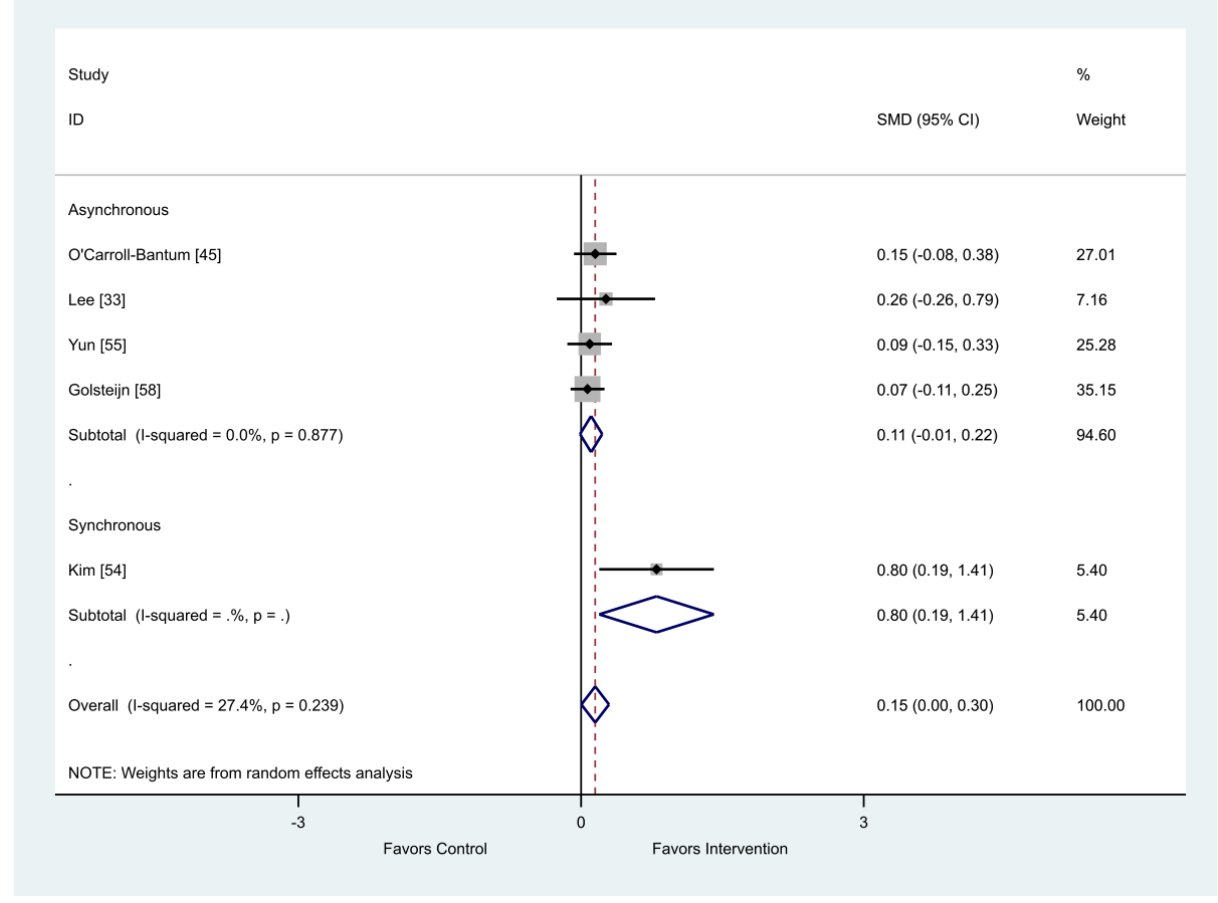
Figure 10. Effect of electronic health interventions with a control on depression interventions, analyzed using standardized mean difference (postintervention mean and SD). Lower scores indicate improved depression. SMD: standardized mean difference.